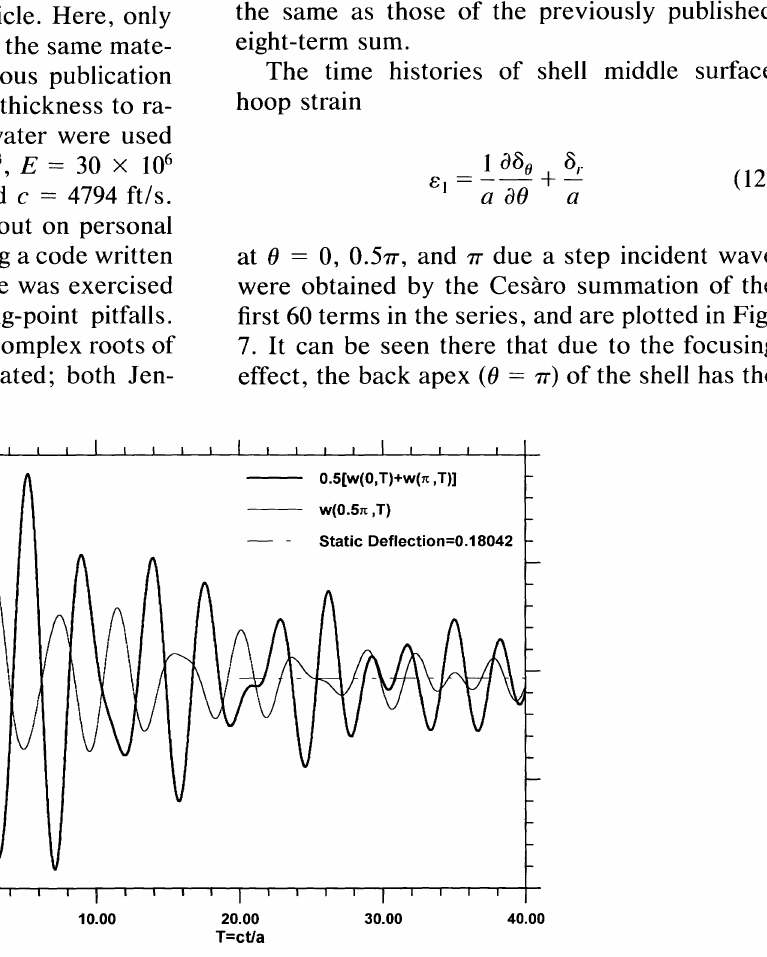
FIGURE 6 Time histories of w(O, T) due to a step incident